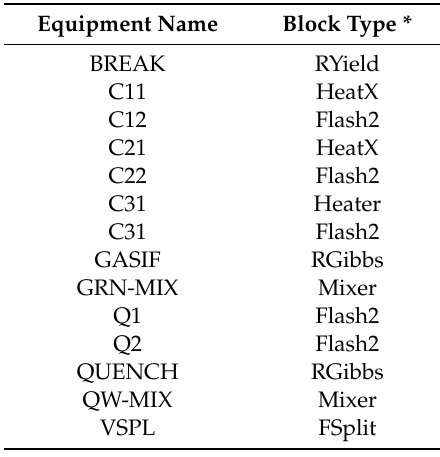
Table 5. Equipment shown in Figure 2. Legend: HeatX—heat exchanger, RYield—yield reactor, RGibbs—Gibbs reactor, FSplit—splitter, Flash2—flash drum. * Properties and purposes of block types are well described in the Aspen Plus User Guide